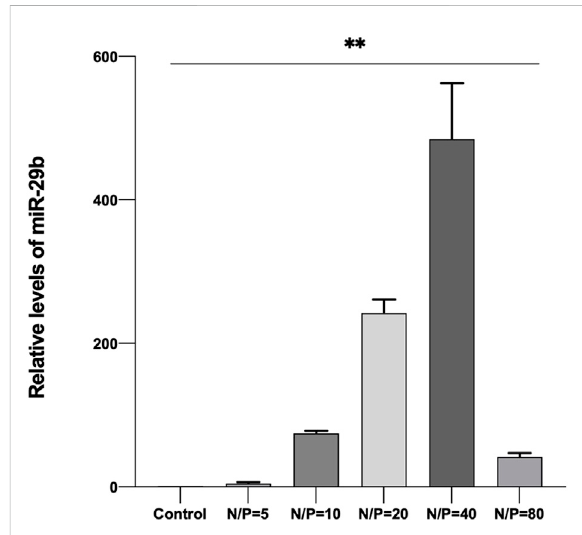
FIGURE 7 Relative quantity of miR-29b in BMSCs after co-incubation with miR-29b/GO-PEG-PEI complex with different N/P ratios (0, 5, 10, 20, 40, and 80) for 3 h. ** p < 0.01.